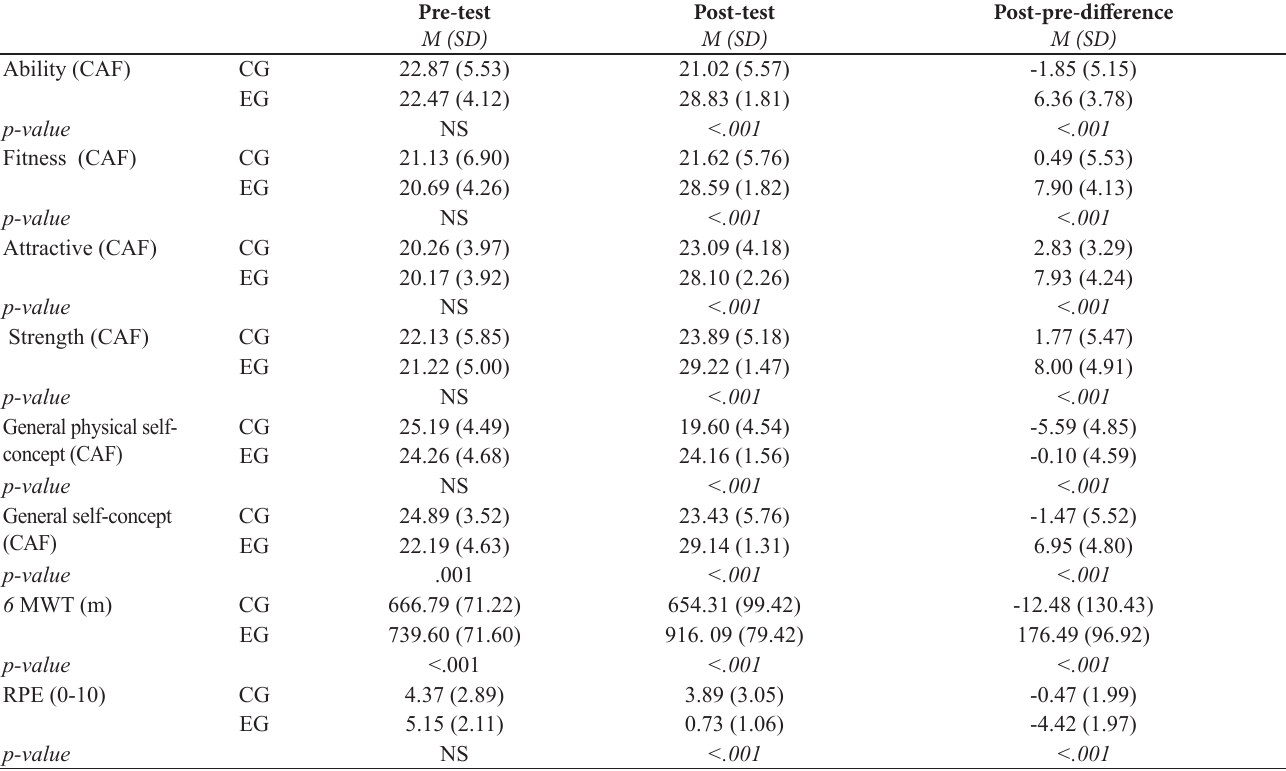
Table 2. Results obtained in physical self-concept questionnaire (CAF), six-minute walk test (6MWT) and RPE. Pre-test